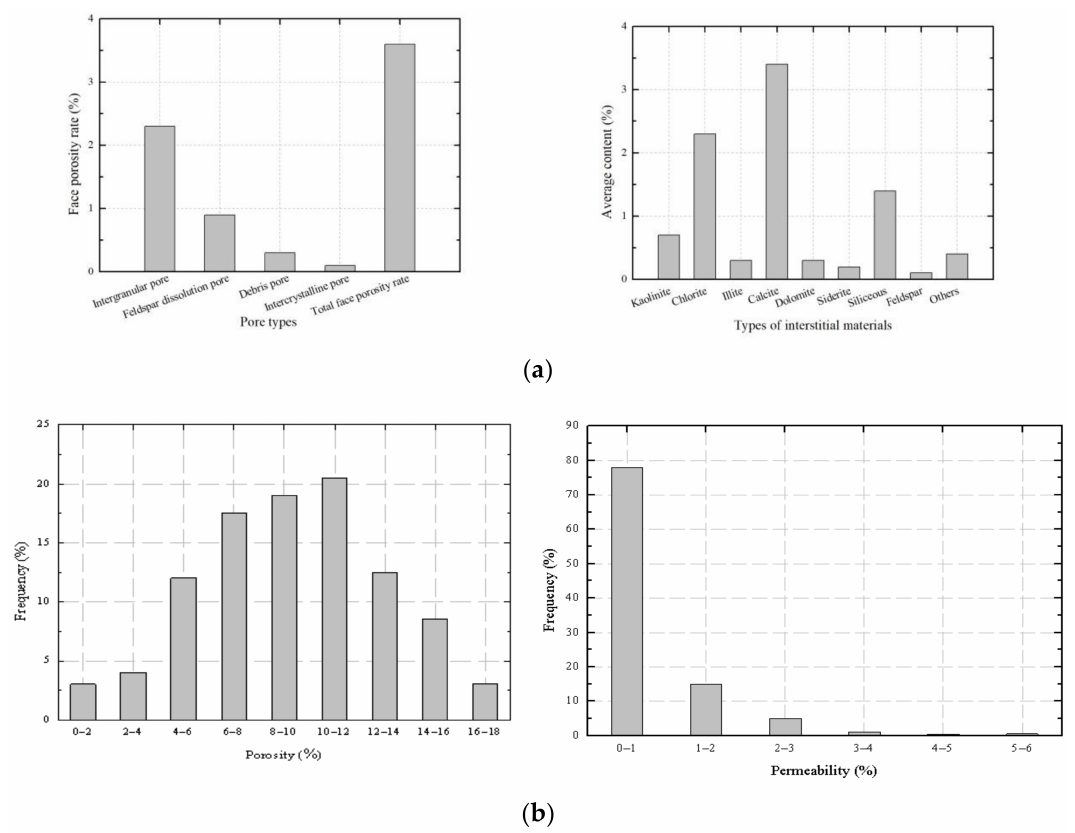
Figure 3. ( a ) Histogram of the pore types and interstitial materials content; ( b ) histogram of porosity and